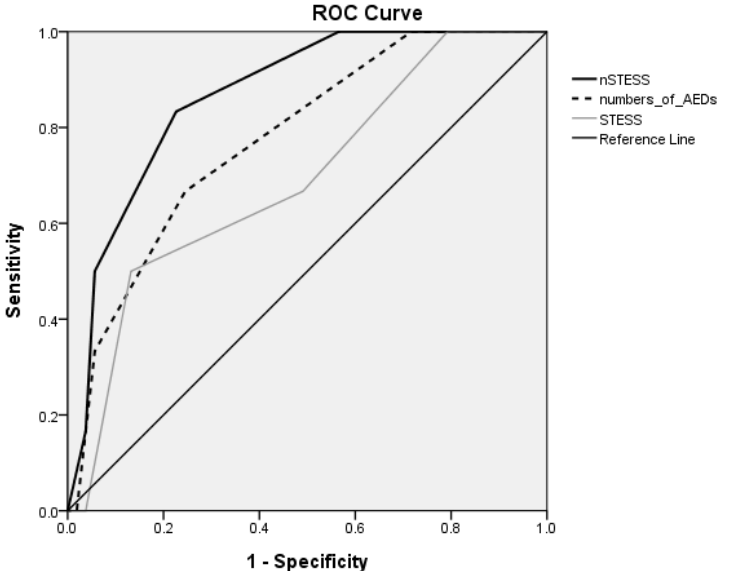
Figure 1. ROC curves of nSTESS, numbers of AEDs, and STESS in our patients. AED, antiepileptic drug; ROC, receiver operating characteristic; STESS, Status Epilepticus Severity Score; nSTESS, newly modified STESS. Table 3. Capacity of the new scale (nSTESS) versus the STESS, mSTESS, and END-IT to predict